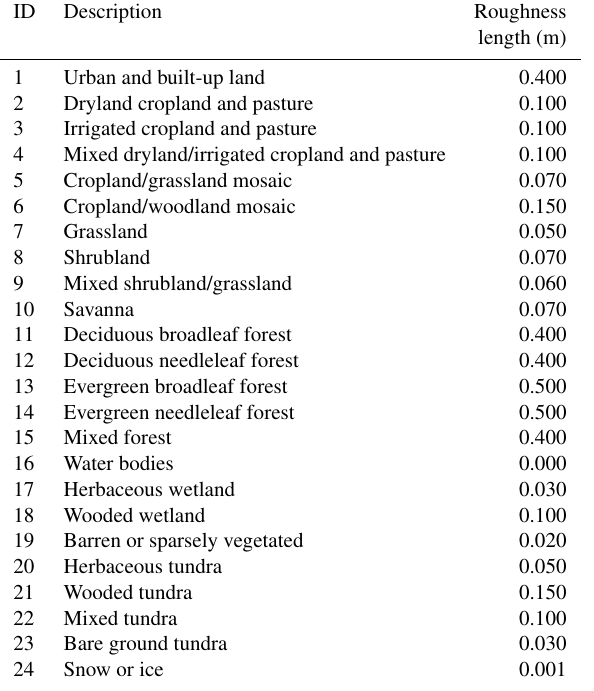
Table A1. Land cover table used for the GLCC database